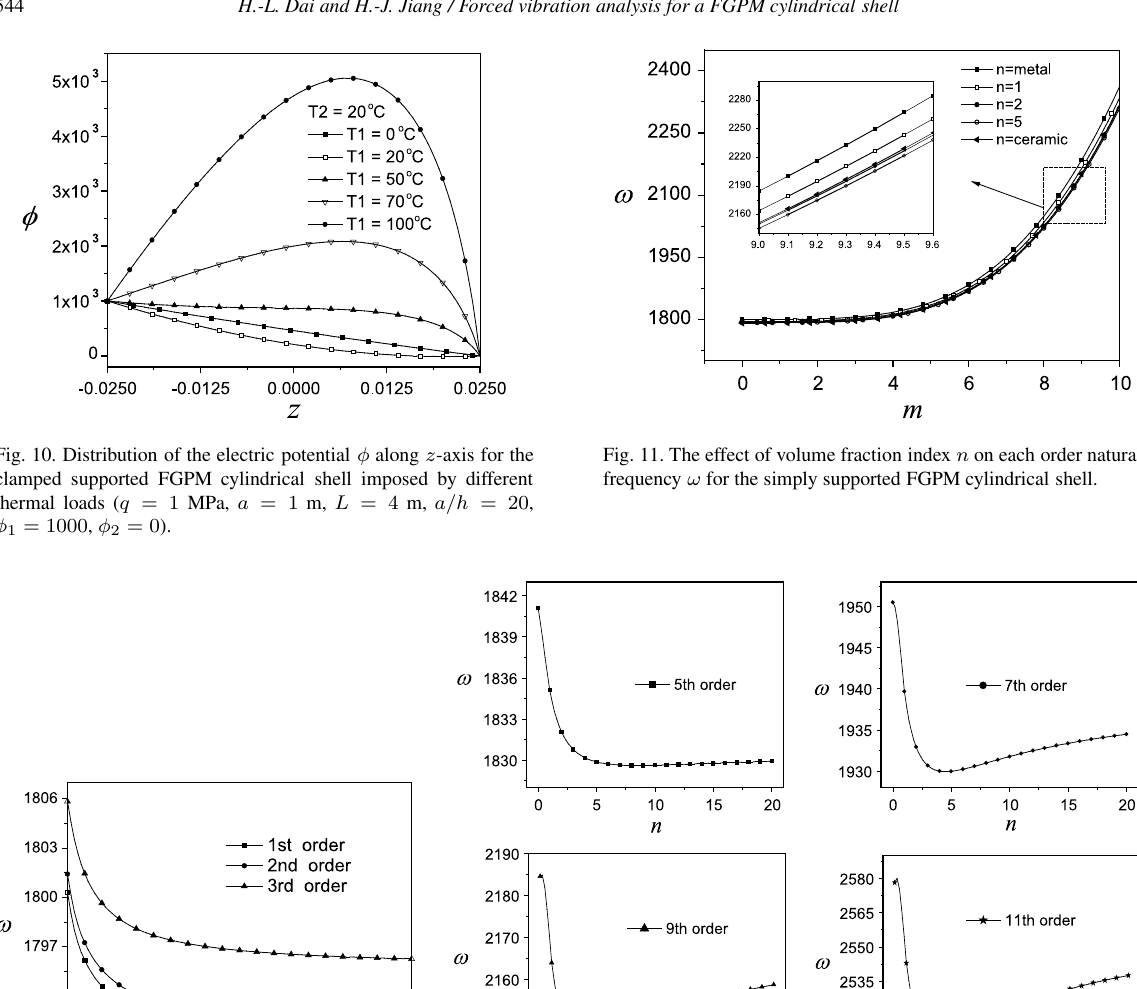
Fig. 13. The effect of volume fraction index n on the high order natural frequency ω for the simply supported FGPM cylindrical